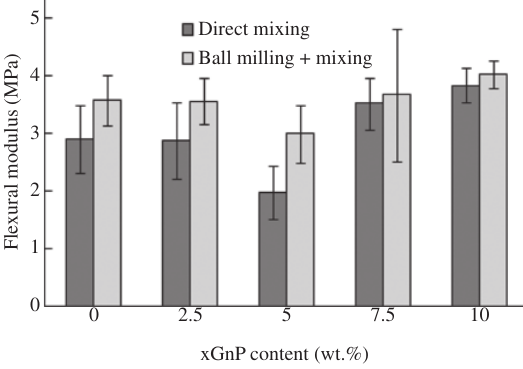
Figure 6: The effect of the xGnP on the flexural moduli of the PP/SG/xGnP composites.